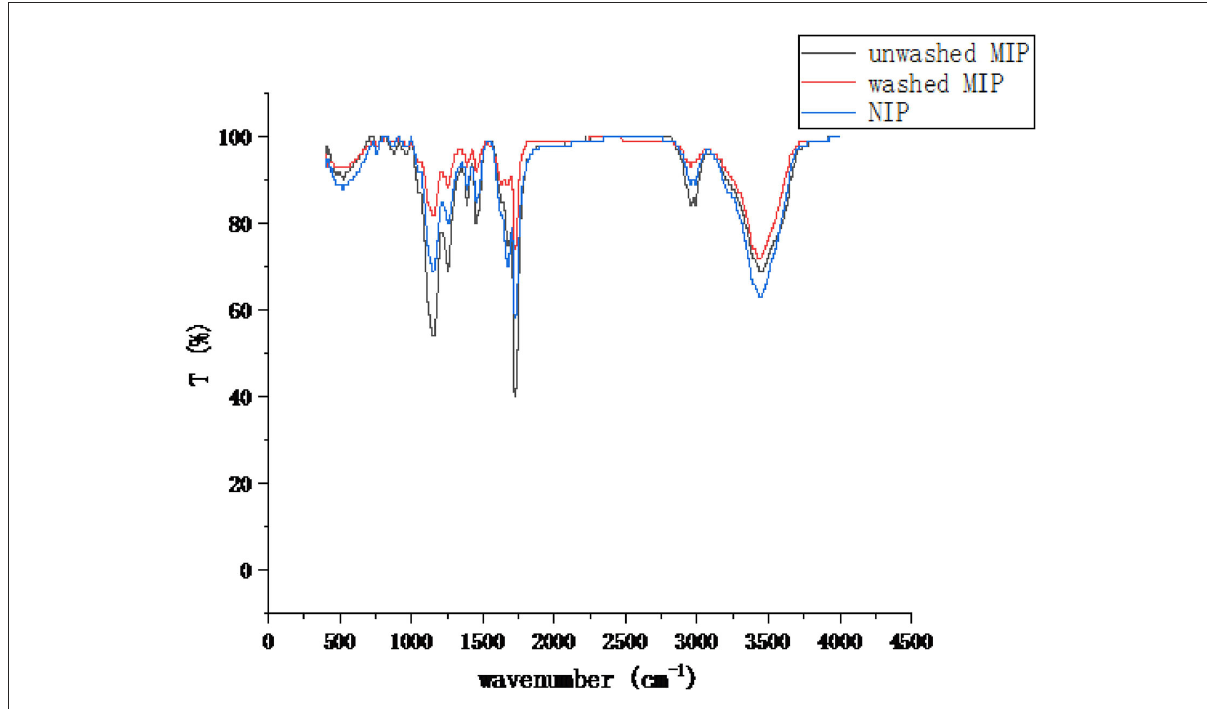
FIGURE6 FTIR of unwashed MIP, washed NIP, and NIP.